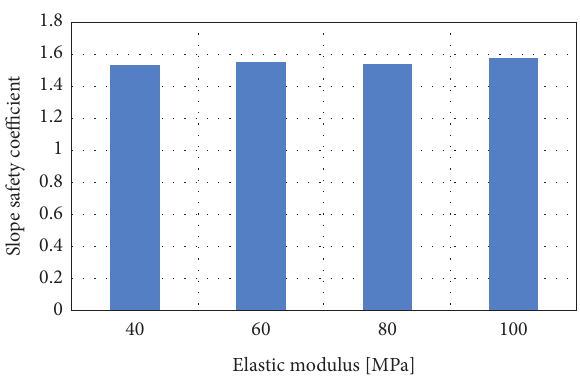
Figure 6: Relationship between the elastic modulus and safety coefficient ( c � 15kPa; φ � 25 °